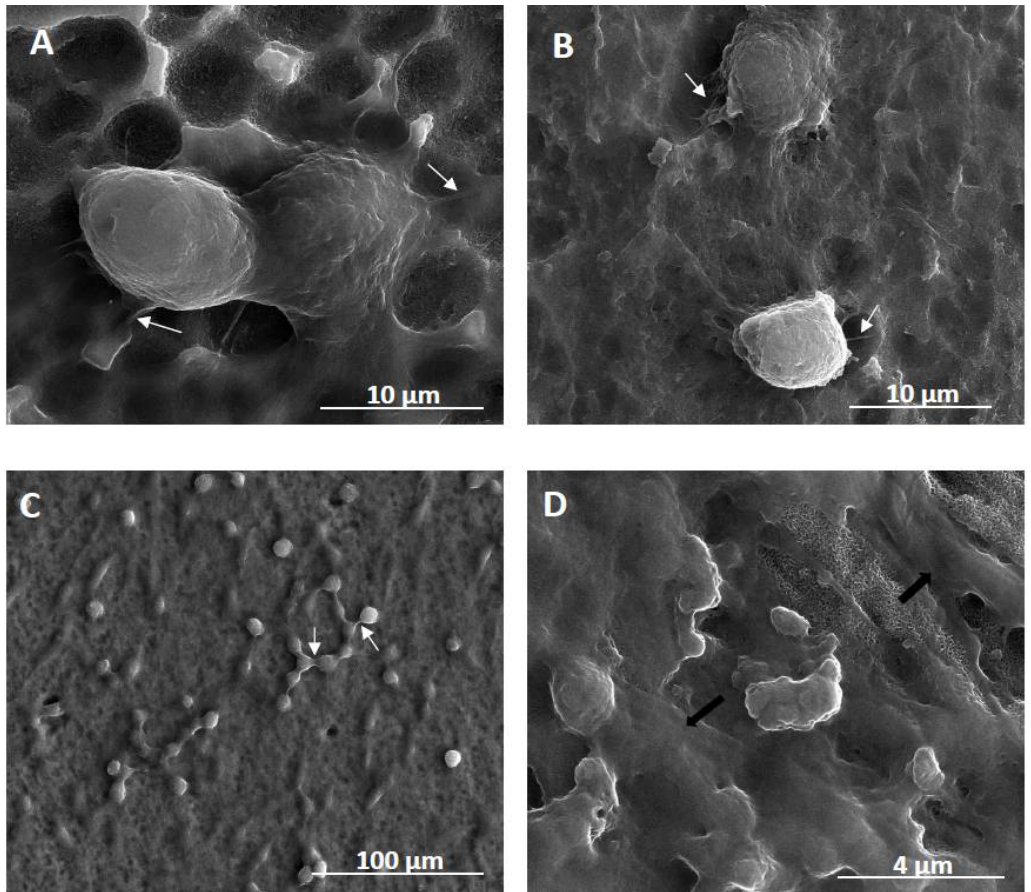
Figure 7. Scanning electron microscopy (SEM) images presenting the cells growing on the surface of fibrous nanocoatings. ( A )—adipose-derived stem cells (ADSCs) “invading” the surface of TNF72a nanocoatings after 24h; ( B )—ADSCs co-cultured with L929 fibroblasts on the TNF72a samples for 24 h; ( C )—successful co-culture of ADSCs and L929 fibroblasts after 72h; ( D )—successful co-culture of ADSCs and MG-63 osteoblasts after 72h. White arrows in the micrographs indicate filopodia that